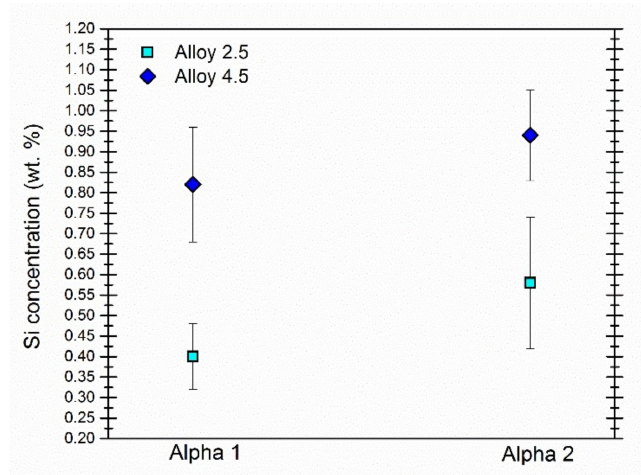
Figure 8. Concentration of Si in α 1 and α 2 -Al phases in alloy 2.5 and 4.5.